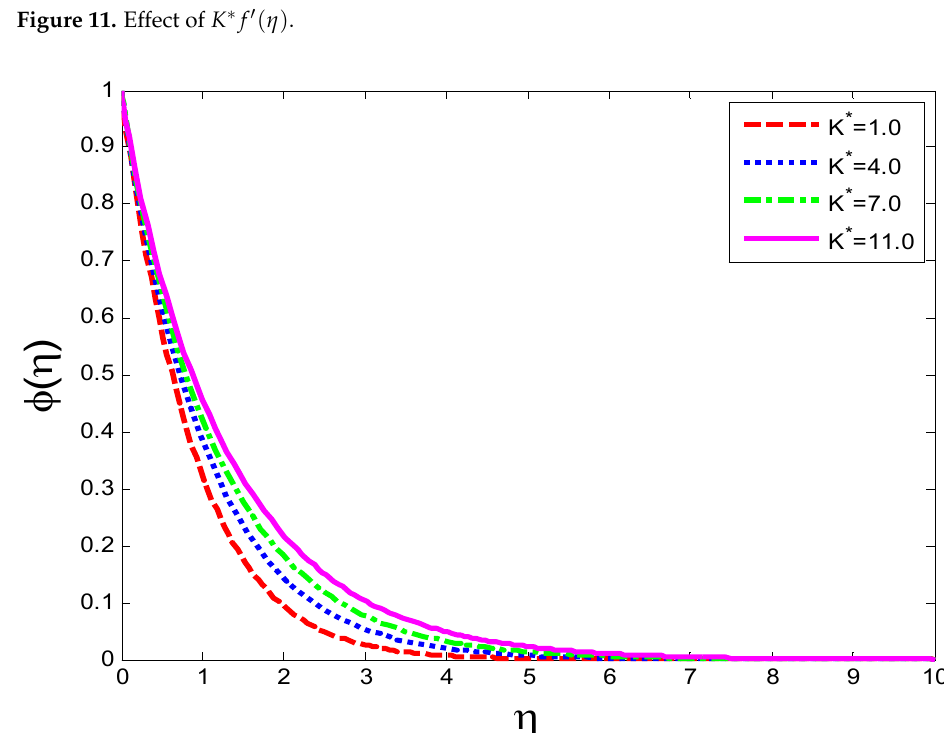
Figure 12. Effect of K ∗ on φ ( η )